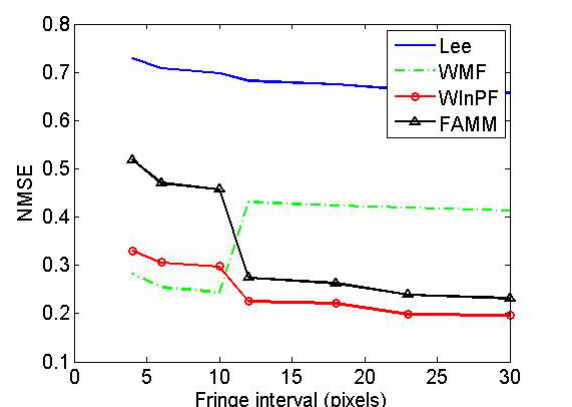
Figure 4: The relationship between the number of pixels between fringes and the NMSE of the simulated interferogram shown in Figure 3.